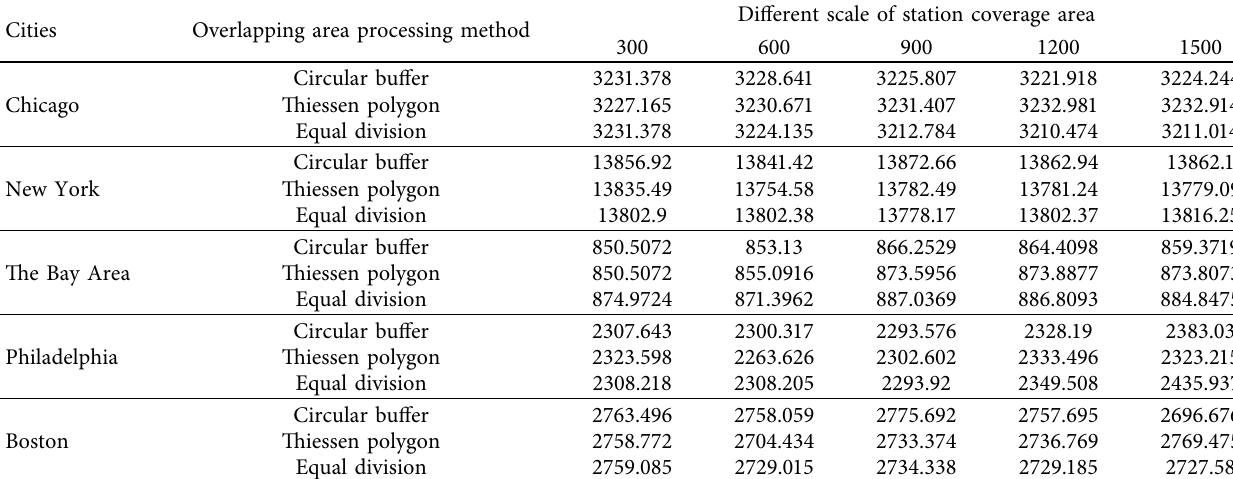
Table 11: Table of the AIC of linear regression model in five cities.